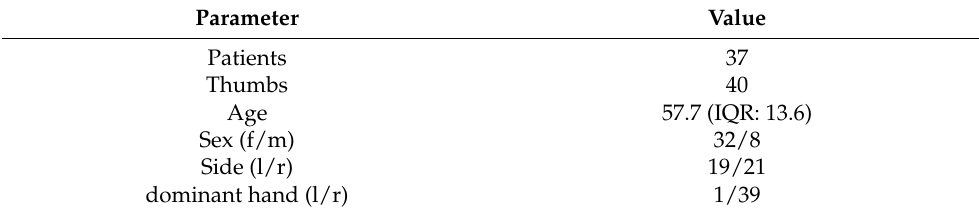
Table 1. Patient demographics.